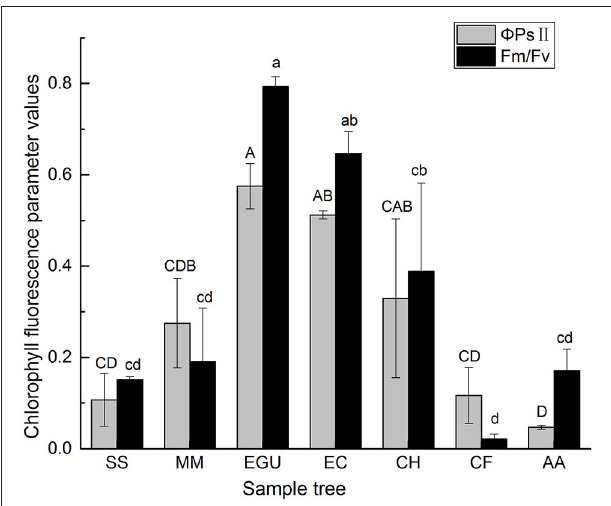
FIGURE 2 | The comparison of chlorophyll fluorescence parameters ( F v / F m , Φ PSII ) among the seven studied trees. Data are the mean ± SE ( n = 3). Letters indicate significant among different species according to Duncan’s test; p < 0.05 (capital letters for Φ PSII and lowercase letters for F v / F m ). Species notations same as above.